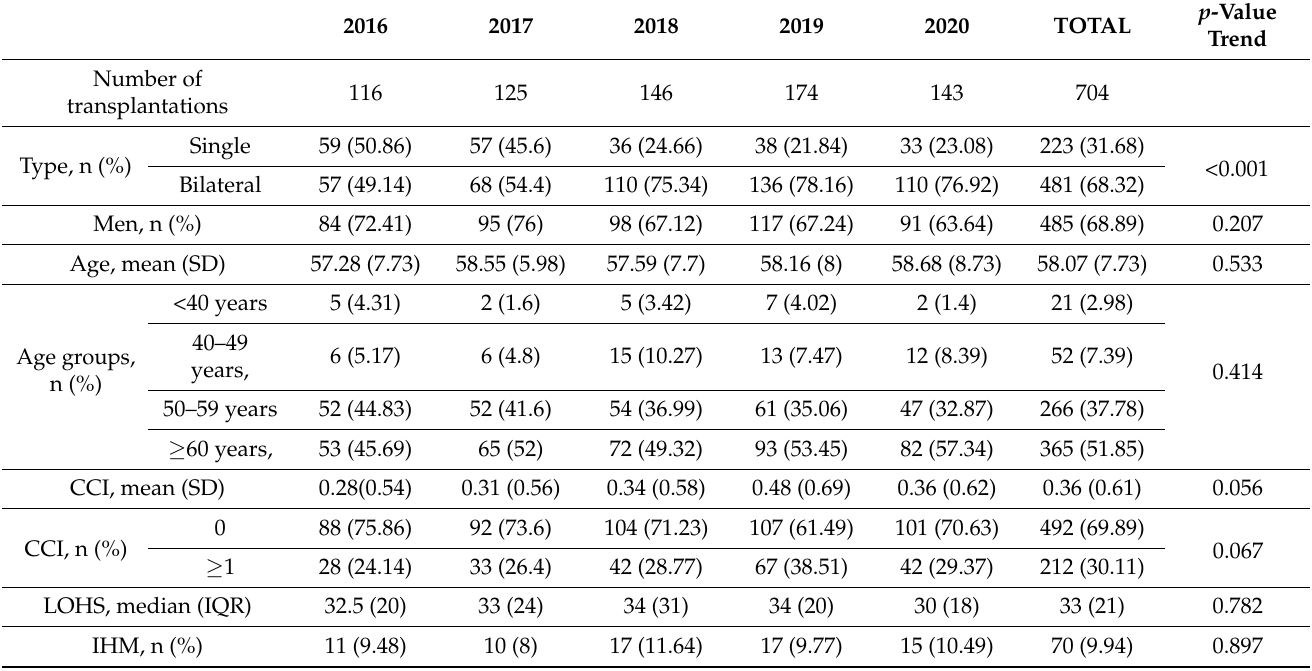
Table 1. Clinical characteristics of patients with COPD who underwent a lung transplantation in Spain from 2016 to 2020.